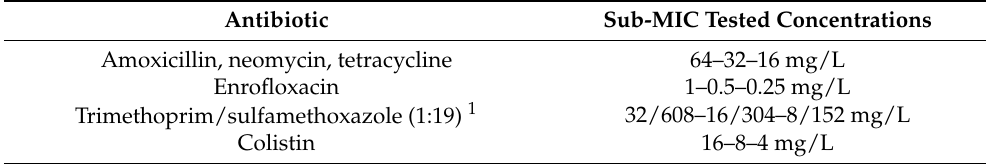
Table 11. Range of AB sub-MIC concentrations when analyzed in MIC tests in